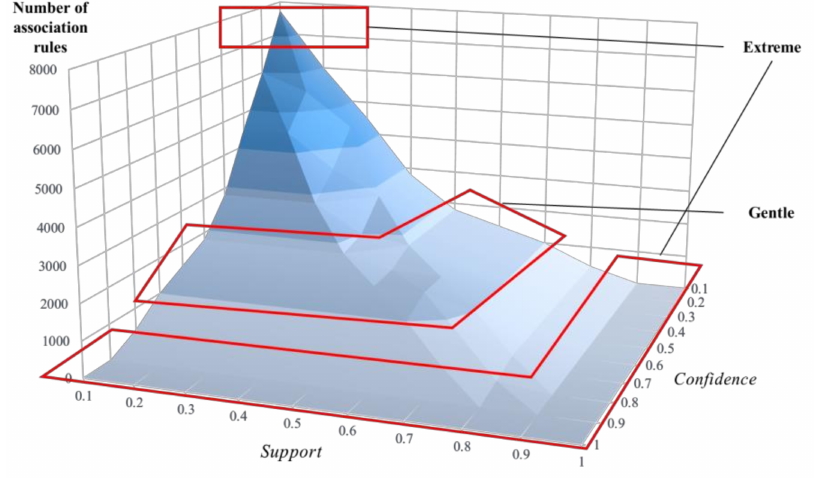
Figure 7. Influence of different parameters values on the number of association